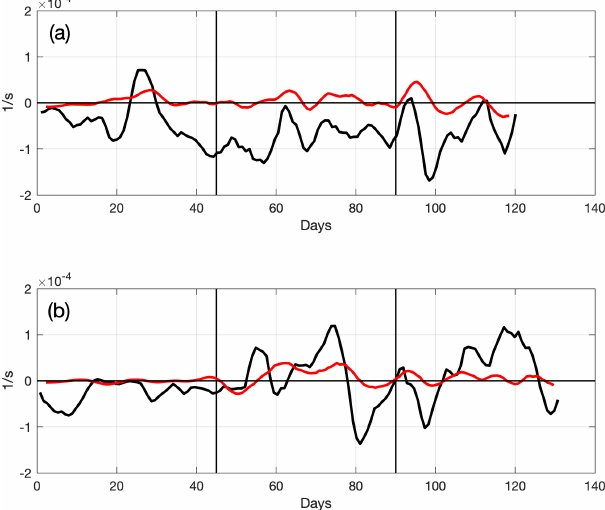
Figure 6. Time series in the central deep area of the rotating tank (flat bottom): the vorticity rate of change ( 1 rate of change of the lower-layer thickness ( 1 EXP24 (a) and EXP27 (b) . For reference, see Eq. (1) when slope s = 0. “Days” stand for rotation days.